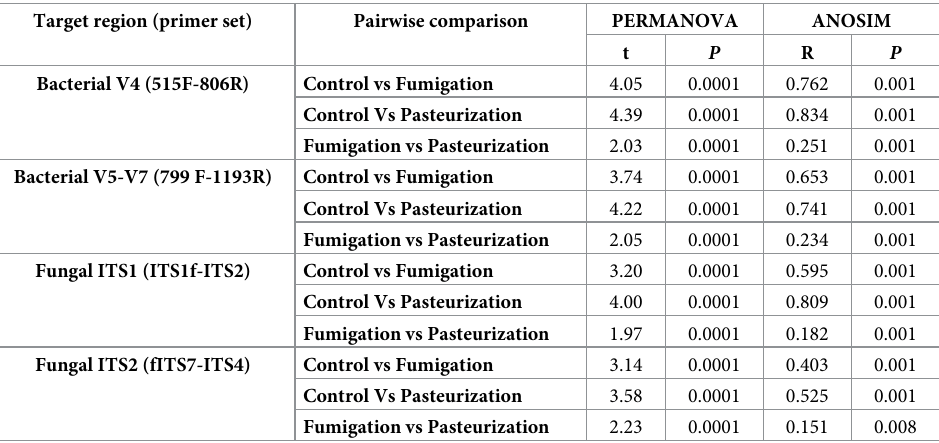
pseudo-F = 22.86, P = 0.0001 for V4 region; and pseudo-F = 20.85, P = 0.0001 for V5-V7 region; ANOSIM: R = 0.60, P = 0.001 for V4 region; and R = 0.54, P = 0.001 for V5-V7 region). Furthermore, for both primer sets, bacterial root community composition differences were significant between all pairs of preplant soil treatments (pairwise PERMANOVA, P = 0.0001; ANOSIM, P = 0.001) (Table 2). NMDS ordination of the BC-dissimilarities generally clustered bacterial root communities from samples of untreated soil separately from those from samples of fumigated and pasteurized soil (Fig 2A and 2B). BC-dissimilarities based on V4 vs. V5-V7 amplicons corresponded closely, based on the RELATE test ( Rho = 0.902, P = 0.0001). Alto- gether, ASVs of class Actinobacteria generally had higher relative abundance in roots from soils (21% in V4, 26.5% in V5-V7) and pasteurized soils (4.4% in V4, 5.4% in V5-V7) Table 2. Effects of preplant soil treatments on bacterial and fungal root communities as revealed by pairwise PER- MANOVA (permutational analysis of variance) and ANOSIM (analysis of similarities) of Bray-Curtis